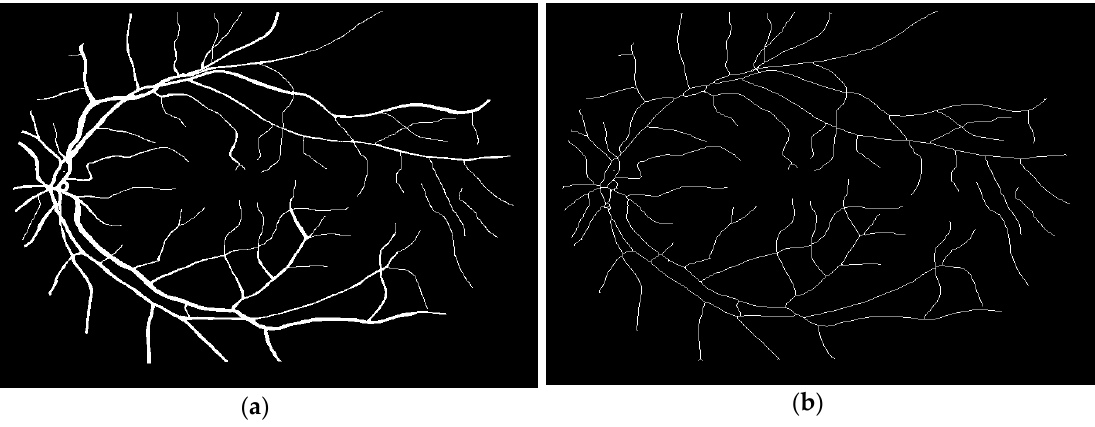
Figure 7. Binarization and skeletonization image: ( a ) Binary image; ( b ) Skeletonization image.